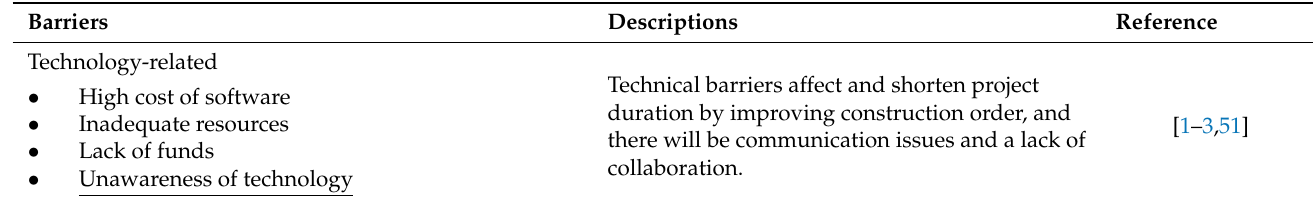
Table 3. Lean principle implementation barriers in construction